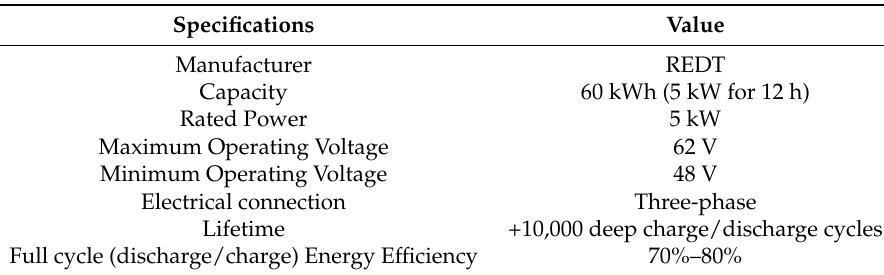
Table 1. VRFB technical